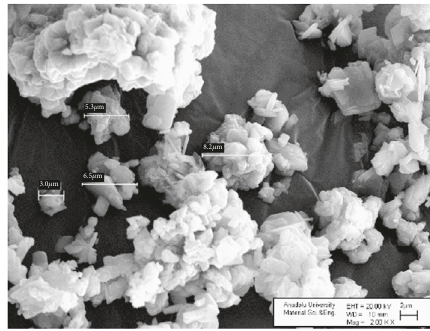
Figure 3: SEM image of ZnB powder